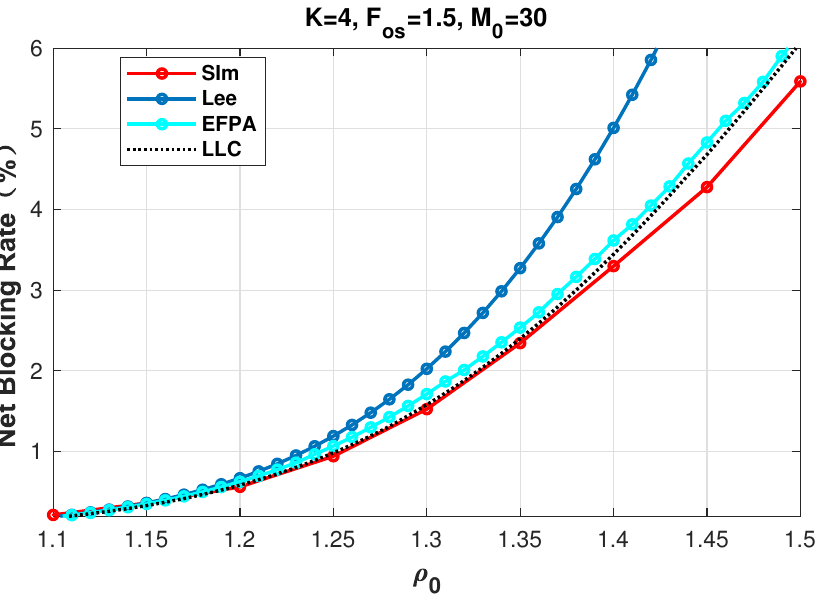
Figure 7. Network blocking performance of different methods with K = 4, F OS = 1.5, and M 0 = 30. For cases with tree factor K = 4 and over-subscription ratio F OS = 2, the simu- lated and analytical blocking rates under different sub-channel numbers are compared